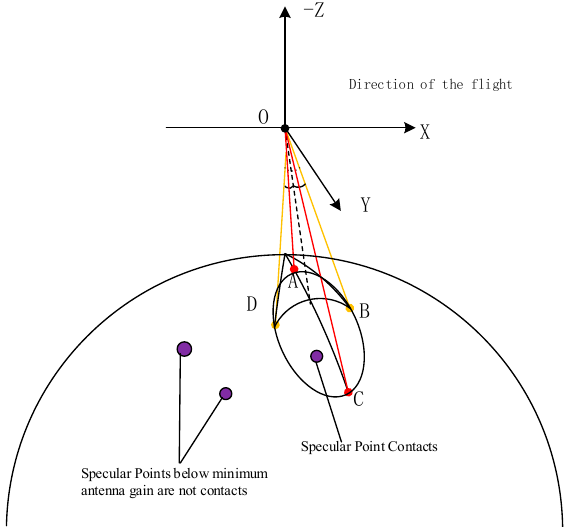
Figure 3. Available reflecting ground coverage for one of the two off-nadir LHCP antennae. Only the signals reflected from specular points which located in the green area can be received by the GNSS-R instrument on the LEO observatory.